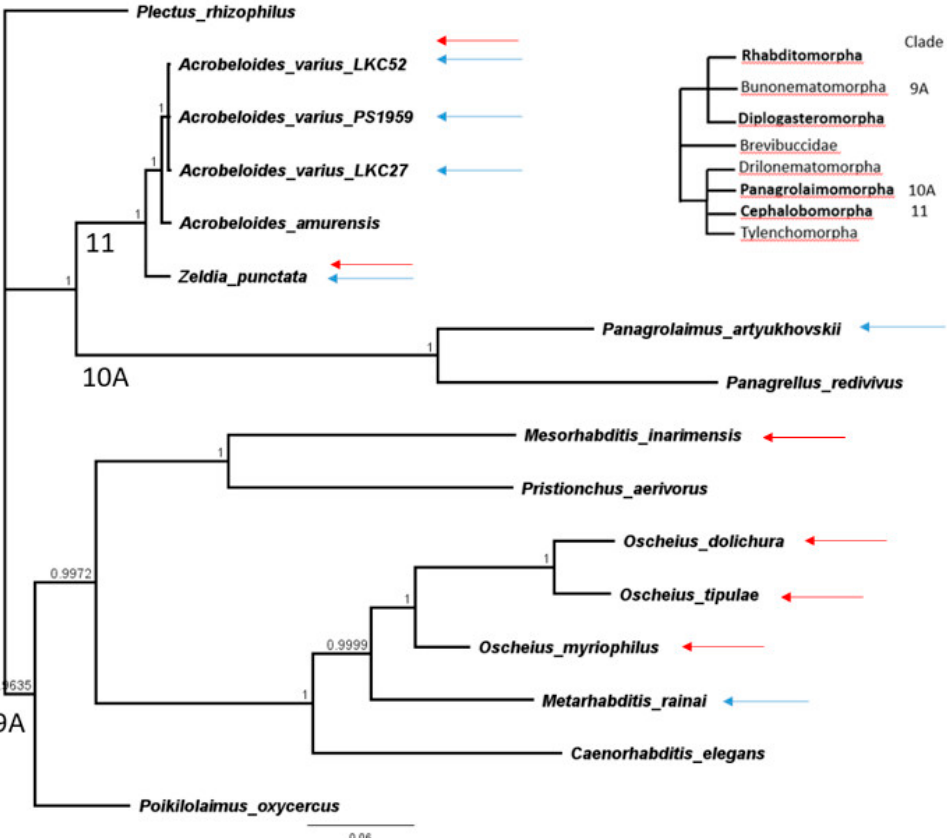
Figure 1. MRBAYES Bayesian likelihood phylogenetic tree based on a Clustal W alignment of 18S rDNA sequences as implemented in Geneious ver. 11.1.5. Upper right schematic tree of van Megen et al., 2009 [23] provides phylogenetic context. Blue and red arrows indicate taxa resistant to P . pulmonarius and P. ostreatus , respectively.